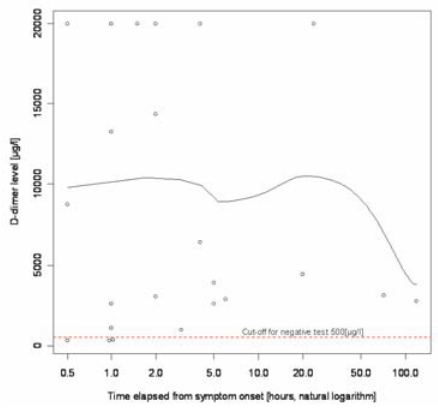
Figure 1 Scatter plot with locally weighted regression line of time from symptom onset and level of D-dimer reading.